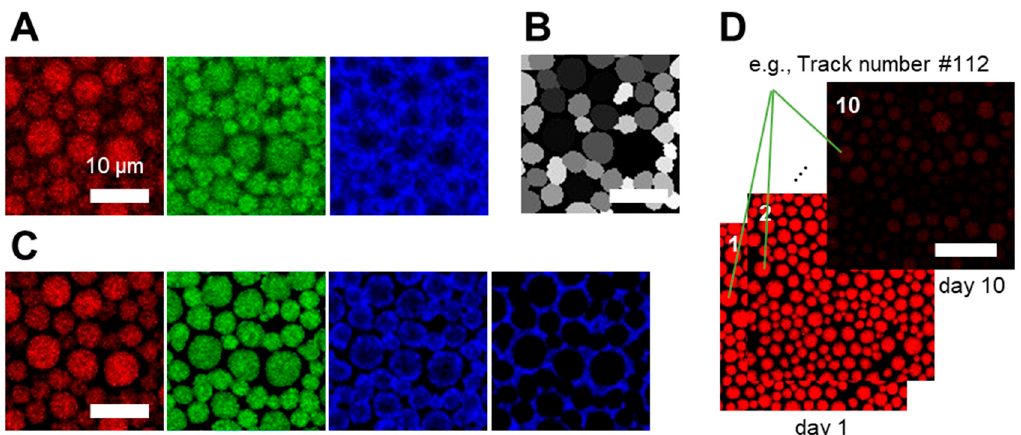
Figure 2. Workflow for the segmentation and tracking of individual oil droplets. ( A ) Original images (raw data) were collected in three separate channels (red, green, and blue). ( B ) Droplets were segmented using StarDist. ( C ) Segmented images were reconstructed by applying the segmentation mask (StarDist) to the original images. The blue channel images represent intensity within and outside the mask corresponding to oxidized proteins at the interface and in the continuous phase. ( D ) Segmented images that have clear borders were stacked together for tracking. Each droplet was tracked using Trackmate for up to 10 days. Tracking numbers were allocated to individual droplets. Scale bars represent 10 µm in ( A – D ). Table 2. The number of droplets and average radius size from analyses for samples I, II, and III (see Table 1).